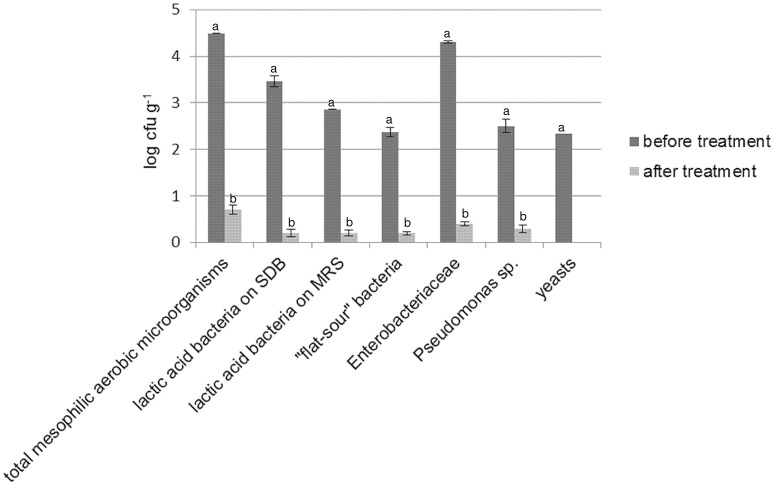
Cell density (log cfu g−1) of total mesophilic aerobic microorganisms, presumptive lactic acid bacteria (enumerated on both SDB and MRS), “flat-sour” bacteria, Enterobacteriaceae, Pseudomonas sp., and yeasts in durum wheat flour before and after treatment with γ-rays at 10 kGy. Within the same microbial group, histogram bars with different letter are significantly different (P <0.05).